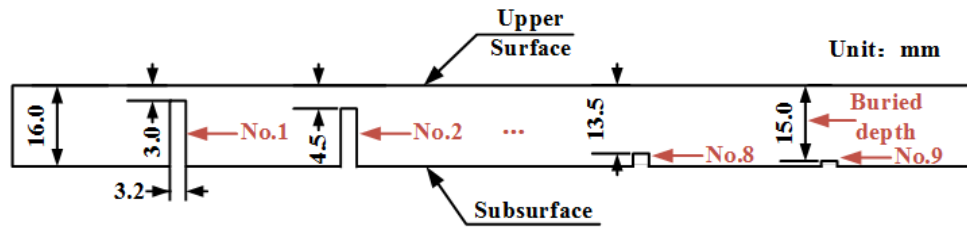
Figure 6. Geometrical sizes of defects in the specimen.